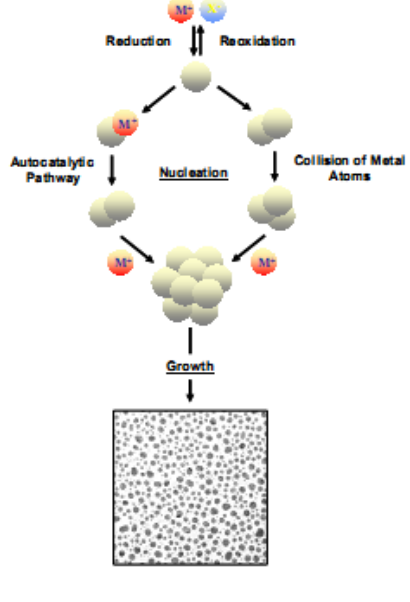
Figure 2. Formation of nanostructured metal colloids via the salt reduction